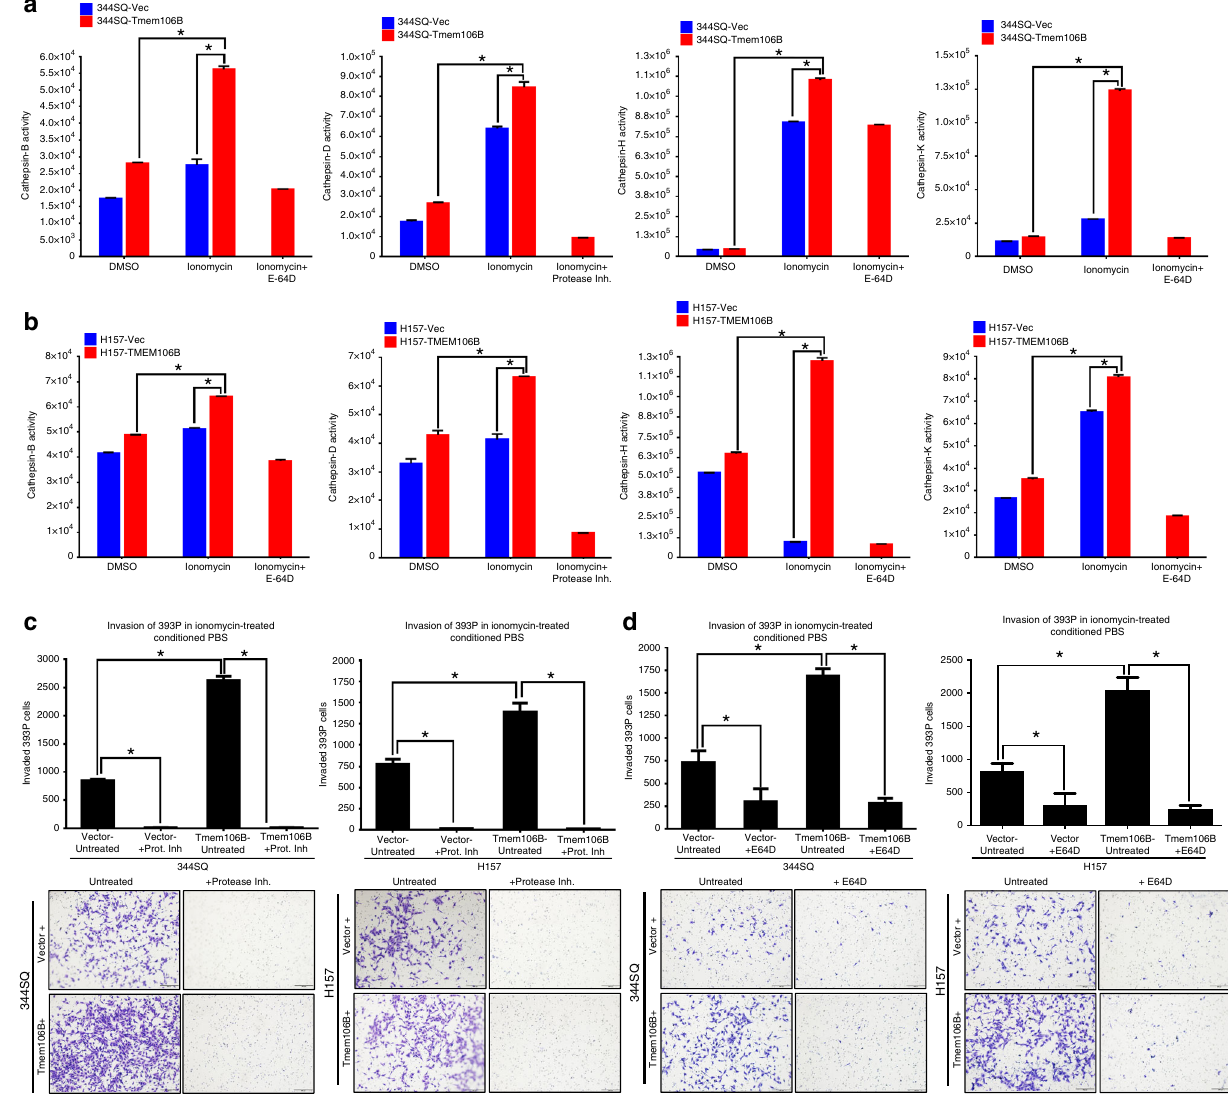
Fig. 7 TMEM106B drives invasion by inducing elevated production and release of cathepsins. a Activity of cathepsins were assessed using speci fi c activity assays in conditioned phosphate buffered saline (conditioned PBS) where lysosomal contents were released by treating mouse, or b human cells expressing either GFP only or TMEM106B, brie fl y with ionomycin or DMSO (as control) in the presence of 2 mM Ca 2 + . Assays were also performed in the presence of speci fi c inhibitors, as indicated. c Invasion assays performed with non-invasive 393P cells, which were incubated with conditioned PBS of human or mouse cells induced for either GFP (Vec) as control or TMEM106B, in the presence of either DMSO as control or a protease inhibitor cocktail. d Invasion assays performed with noninvasive 393P cells, which were incubated with conditioned PBS of human or mouse cells induced for either GFP (Vec) or TMEM106B, in the presence of either DMSO or the irreversible cysteine protease inhibitor (E64D), which speci fi cally inhibits cathepsins B, H,